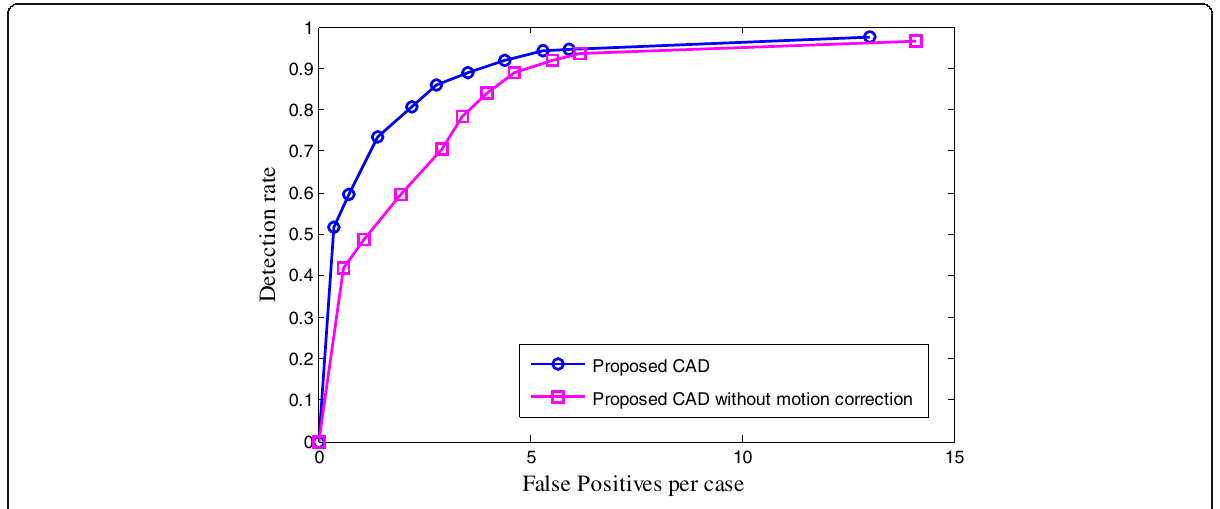
Fig. 7 Comparison of FROC curves for breast lesion detection with and without motion